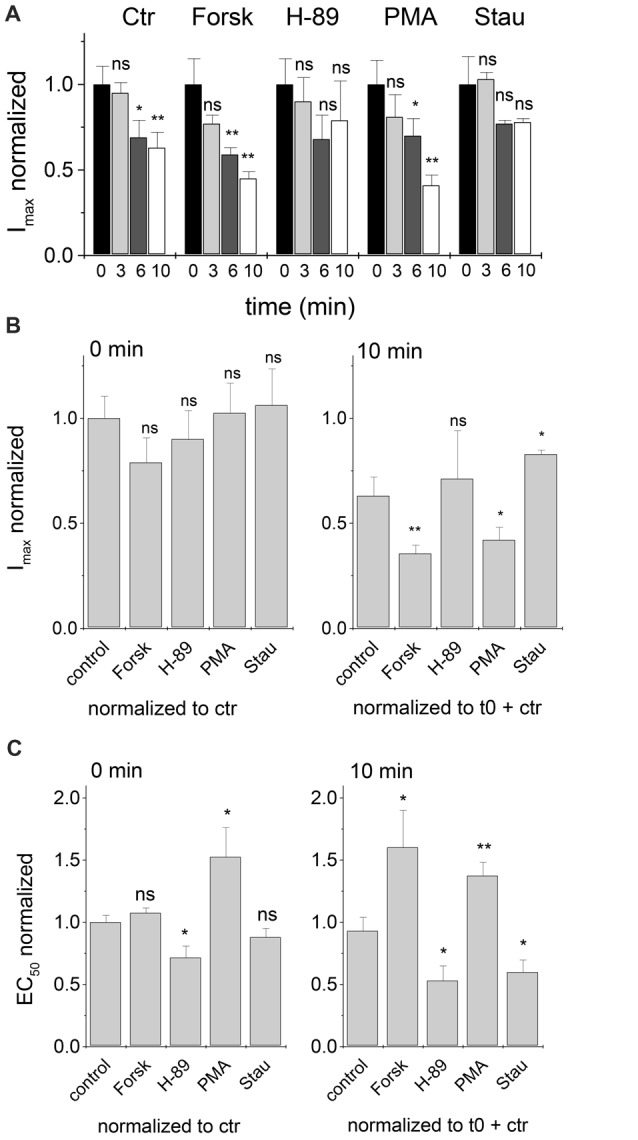
Time dependent development of Imax and EC50 after treatment with PKA and PKC modulators. Changes in Imax and EC50 values were followed for 10 min after the first current recording. Modulator concentrations were 0.25 μM. (A) Comparison of Imax values of PKA and PKC modulators after 0, 3, 6 and 10 min. Imax values were normalized to t = 0. (B) Start (t = 0 min) and end (t = 10 min) maximum currents of various modulators were compared to control currents. (C) EC50 values at t = 0 and 10 min were compared to control values. Half-maximum concentrations of glycine in the presence of PKA and PKC modulators at t = 0 were normalized to control (no modulation). Additionally, 10 min data points were normalized to the corresponding starting EC50 (t = 0). Each data point was measured for at least three cells and normalized EC50 values were averaged. Statistical significance is indicated (*p < 0.05; **p < 0.01; n.s., not significant).